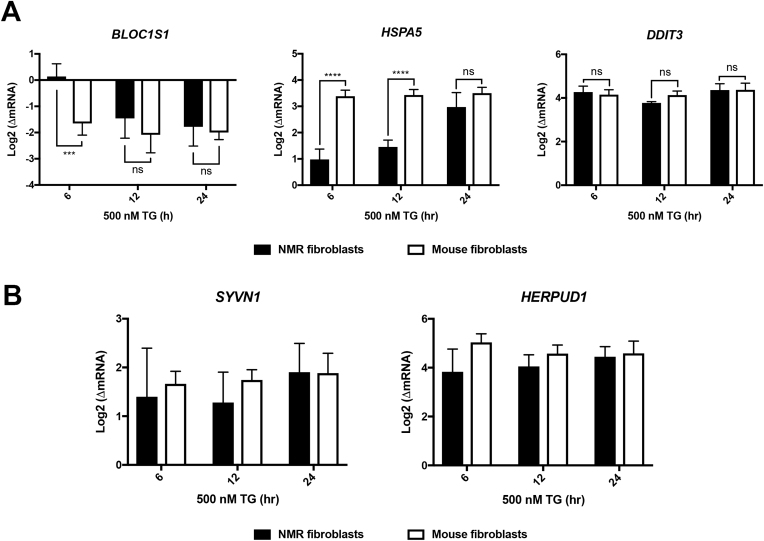
Changes of the UPR and ERAD markers in response to long-term treatment of 500 nM TG in the NMR and mouse kidney fibroblasts.(A) Bloc1s1, Hspa5 and Ddit3 and (B) Svyn1 and Herpud1. All results were presented as mean ± S.D. of log-transformed mRNA fold change compared to the basal-level expression in untreated cells. n = 5 pairs; ns, P > 0.5, ∗∗P < 0.01, ∗∗∗P < 0.001, ∗∗∗∗P < 0.0001; two-way ANOVA tests, Sidak’s multiple comparisons tests.